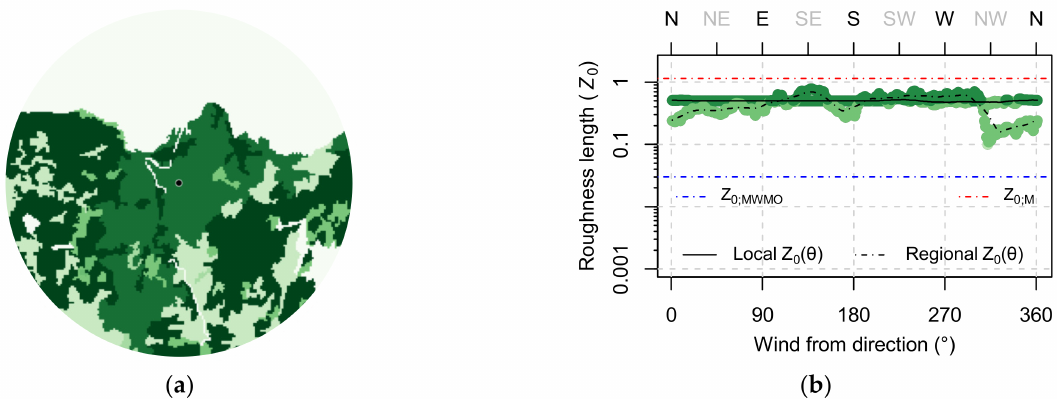
Figure 20. Derived surface roughness for ZEBLL site ( a ) in 10 km radius adapted from CLC map 2 ; ( b ) Directional local and regional surface roughness weighted by distance to building-site. Darker green colour indicates higher surface roughness values.